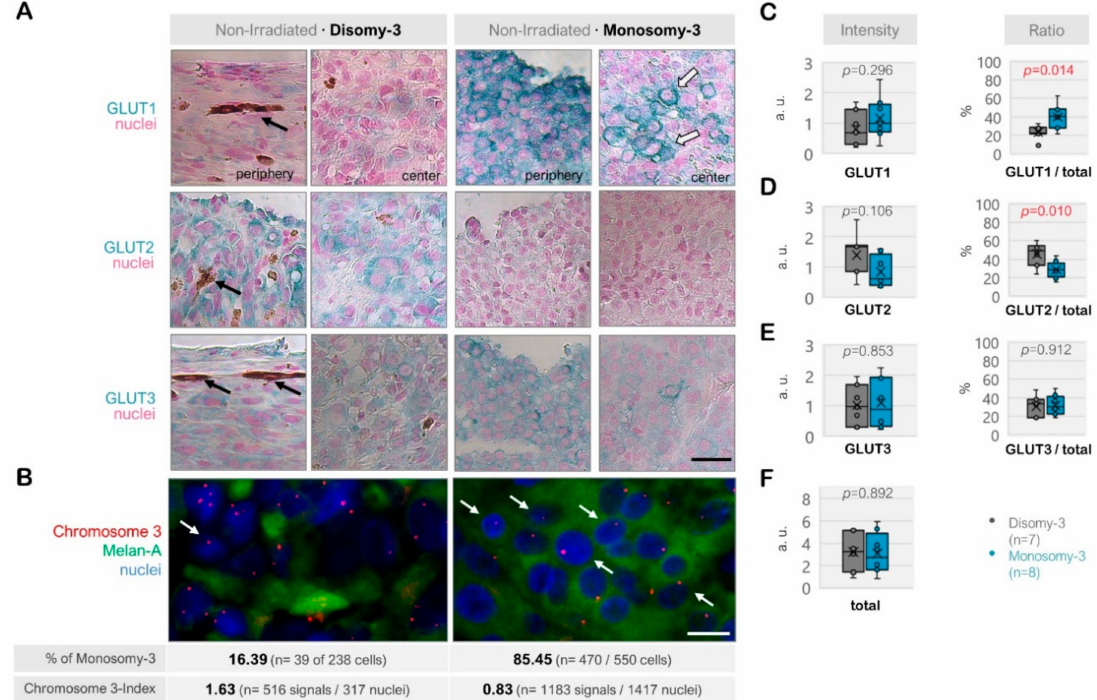
Figure 2. Expression of the glucose transporters GLUT1, GLUT2, and GLUT3 in the non-irradiated uveal melanoma (UM) samples. ( A ) Representative images from the immunostainings for GLUT1-3. The disomy-3 tumor was obtained from a male patient (69 years), who did not develop metastases during the follow-up, whereas the monosomy-3 tumor was removed from a female patient (39 years), who presented with bone metastases that have subsequently spread to the brain. Images were acquired at an original magnification of 200 × . The black arrows indicate the pigmentation whereas the white arrows with a dark contour point out the staining of the plasma membrane. Scale bar = 25 µ m. ( B ) Immuno-Fluorescent in situ hybridization (Immuno-FISH) was performed to detect the copy number of chromosome-3 (red) in the UM cells that were positive for the melanoma marker Melan-A (green). The nuclei were counterstained in blue with 4 (cid:48) ,6-Diamidine-2 (cid:48) -phenylindole dihydrochloride (DAPI). The chromosome 3 status of the tumors was evaluated by determining the percentage (%) of cells with monosomy-3 and the chromosome 3-index as described in the Methods section. The values obtained for these parameters in the previously mentioned tumors are stated underneath the respective image panels ( n : number). Arrows indicate several examples of cells with monosomy-3. Scale bar = 10 µ m. Quantification of the intensity and ratio of ( C ) GLUT1, ( D ) GLUT2, and ( E ) GLUT3 in the primary UMs with regard to the monosomy-3 status. ( F ) The sum of the GLUT1-3 intensities was also presented as the “total.” p -values were determined by the unpaired, two-sided t -test. The significant p -values ( < 0.05) were indicated in red. a.u.: Arbitrary